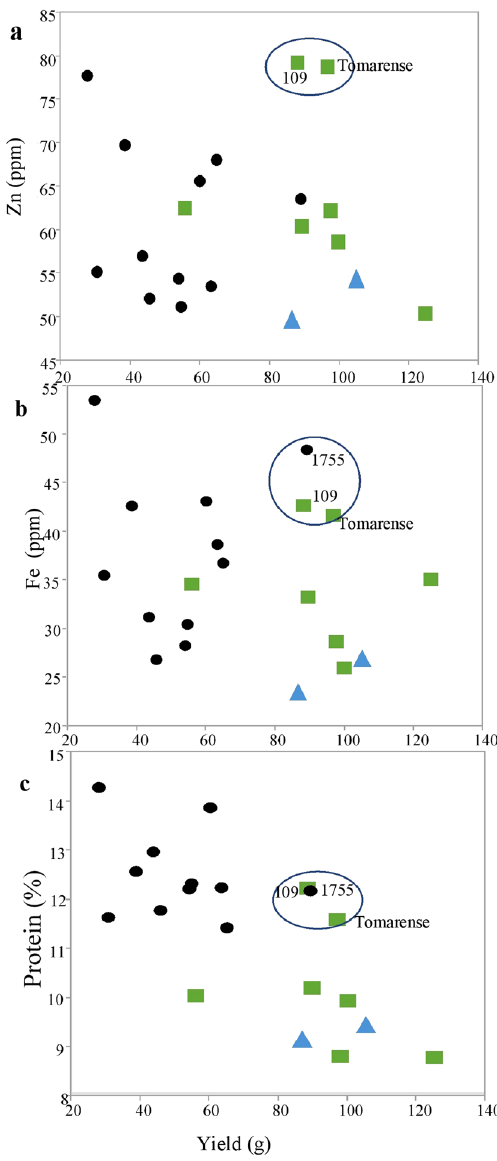
Figure 5. Grain Mineral Concentration and Grain Protein Content compared to Grain Yield. Mean values of Zn, Fe and protein concentration plotted against yield of the 20-line block design (n = 4) experiment (Panel: P4). Mineral concentration (ppm) by inductively-coupled plasma mass spectrometry. Modern bread wheat (blue triangle) Free-threshing spelt (green rectanagle) Hulled spelt (filled circle). The samples marked in blue line circles show high yield and exceptionally high concentrations of Zn and Fe and high GPC values. Tomarense and 109 (Free threshing) showed high values for all three parameters. 1755 (Hulled) did not show an exceptionally high concentration for